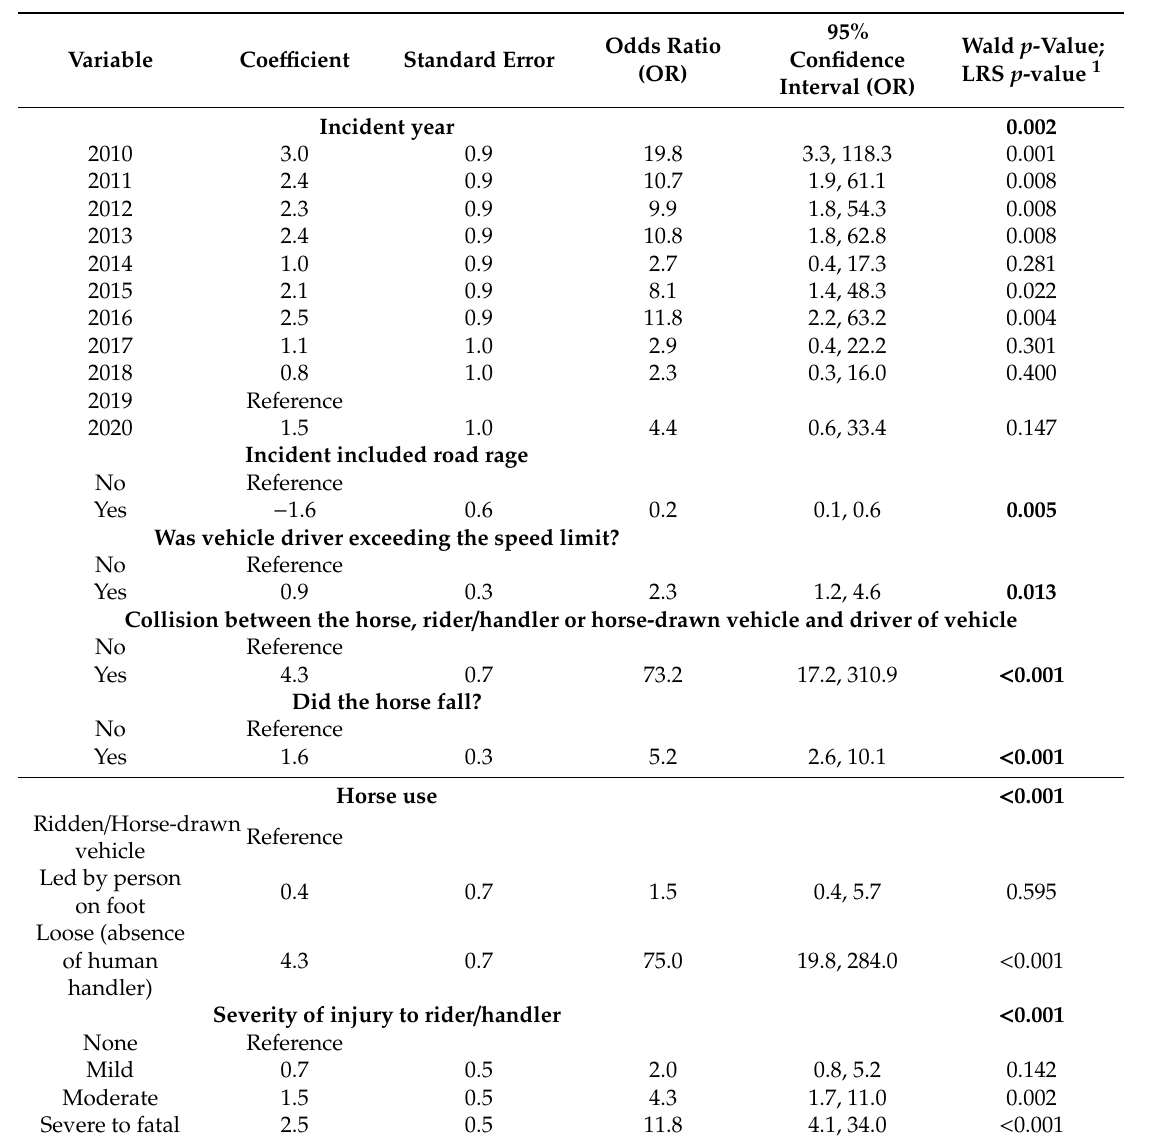
Table 3. Multivariable logistic regression modelling of incident-, horse- and rider / handler-related variables associated with higher odds of horse fatality road incidents ( n = 3709) reported to the British Horse Society between 2010 and